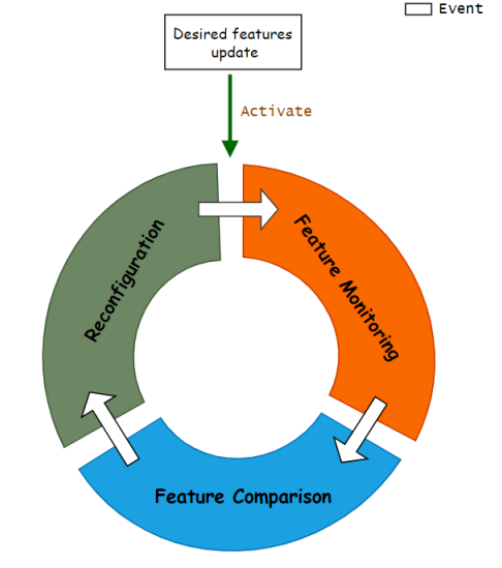
Figure 7. Feature compatibility controller’s control